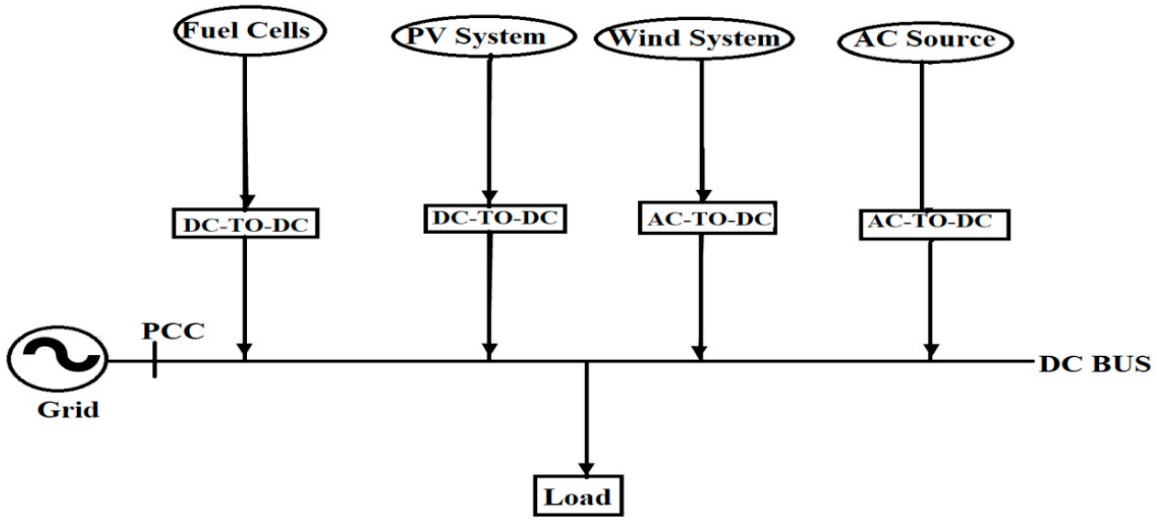
Figure 2. DC Type Microgrid.